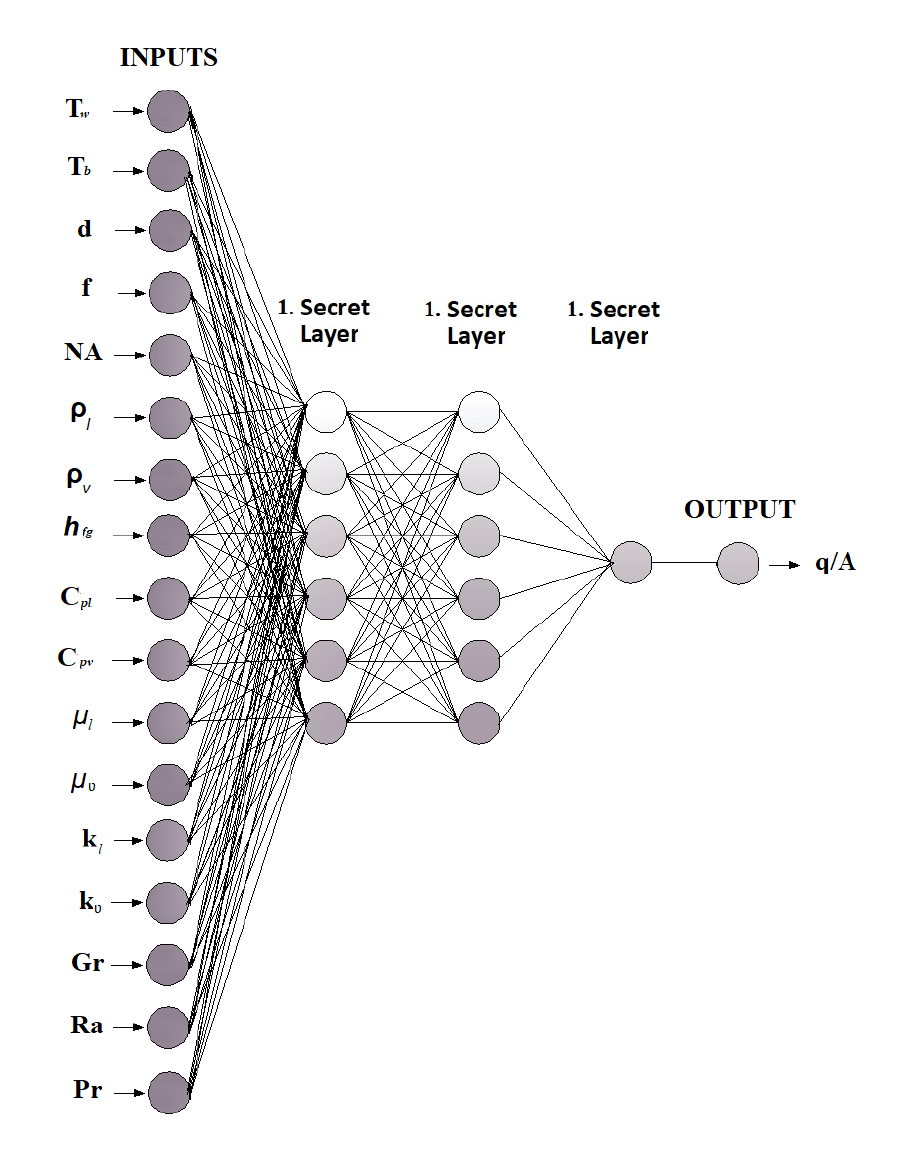
Figure 5. MLP structure. Table 3. The Network structure of